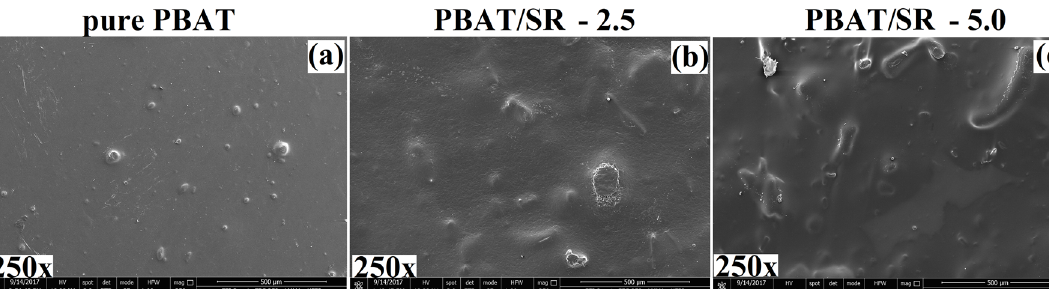
Figure 4. Scanning electron microscopy of the surface: a) pure PBAT and PBAT/SR mulch films without carnauba wax: b) 2.5% and c) with 5.0%. (colored in the online